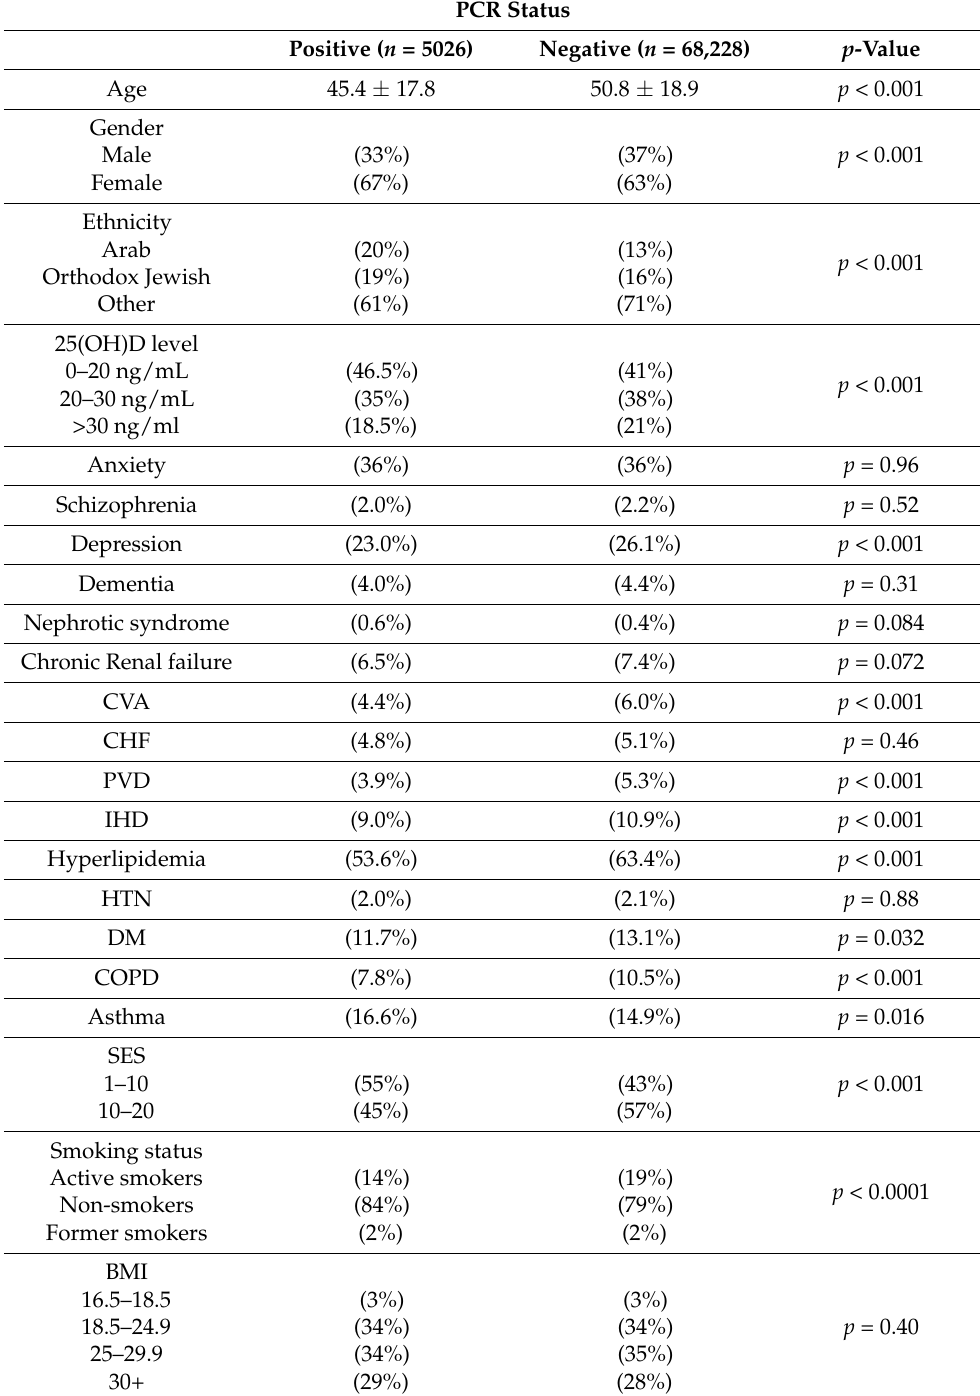
Table 1. Baseline characteristics of the fully vaccinated